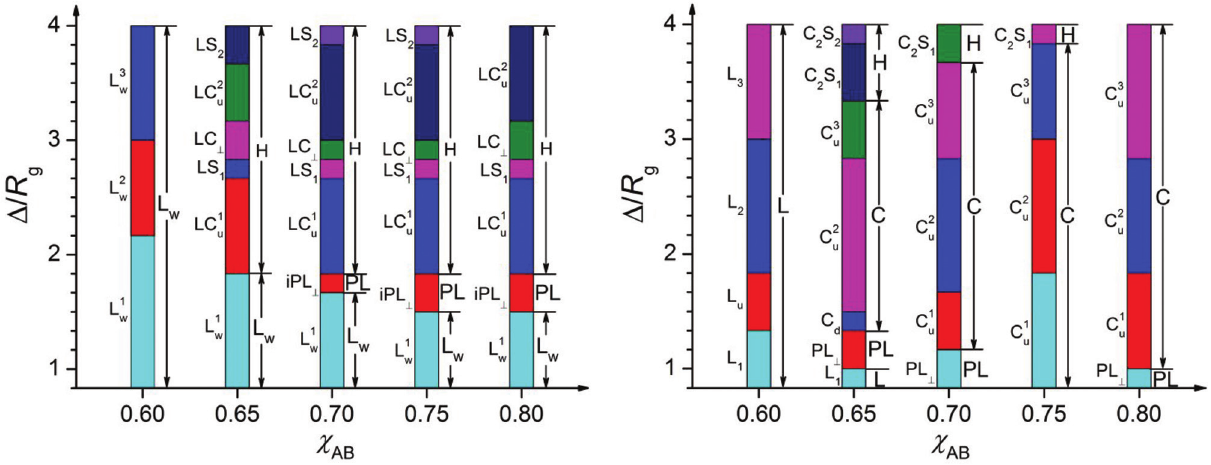
Figure 12: Phase diagram under strong attractive substrate (Λ = 3.0).